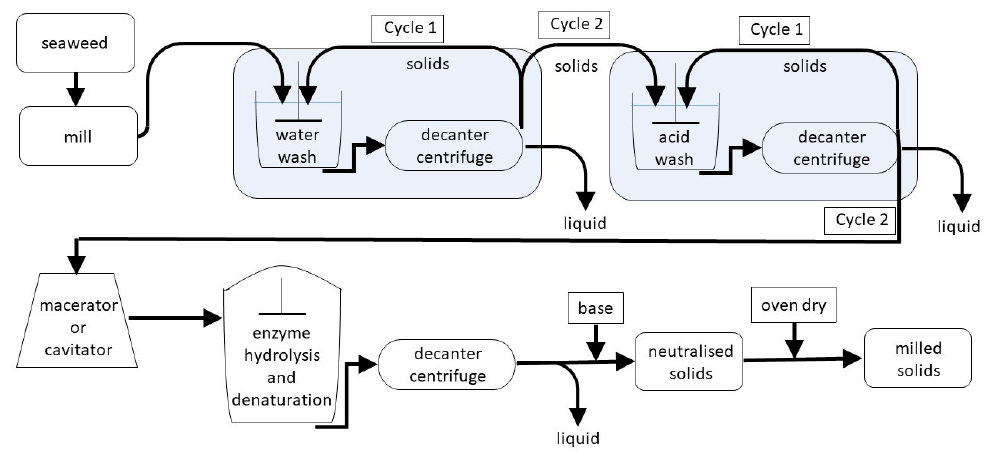
Figure 1. Schematic of macroalgae processing at scale, showing the main steps of the process. Inverted ‘T’s indicate stirring. Between steps, material was stored at 4 °C (overnight) or at − 20 °C (longer term).